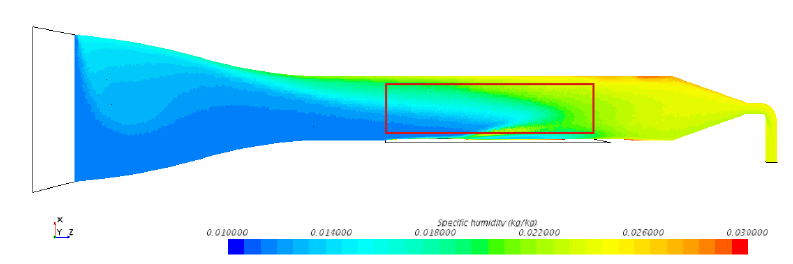
Fig. 4. Simulated specific humidity (Case 1) field in streamwise central plane showing the influence of reverse flow along the top surface of the channel. Red rectangle region is investigated also experimentally (see online version for colors)